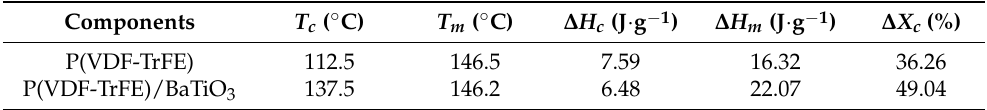
Table 6. Curie temperature ( T c ), melting temperature ( T m ), crystallization enthalpy ( ∆ H c ), melting enthalpy ( ∆ H m ), and material crystallinity ( ∆ X c